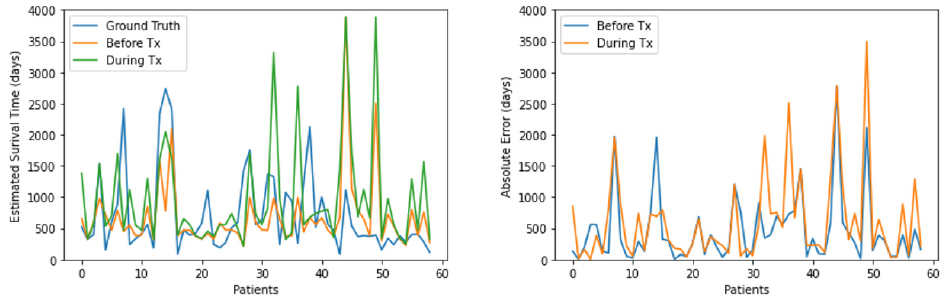
Figure 5. Estimated survival times and absolute error comparison between before and during treat-